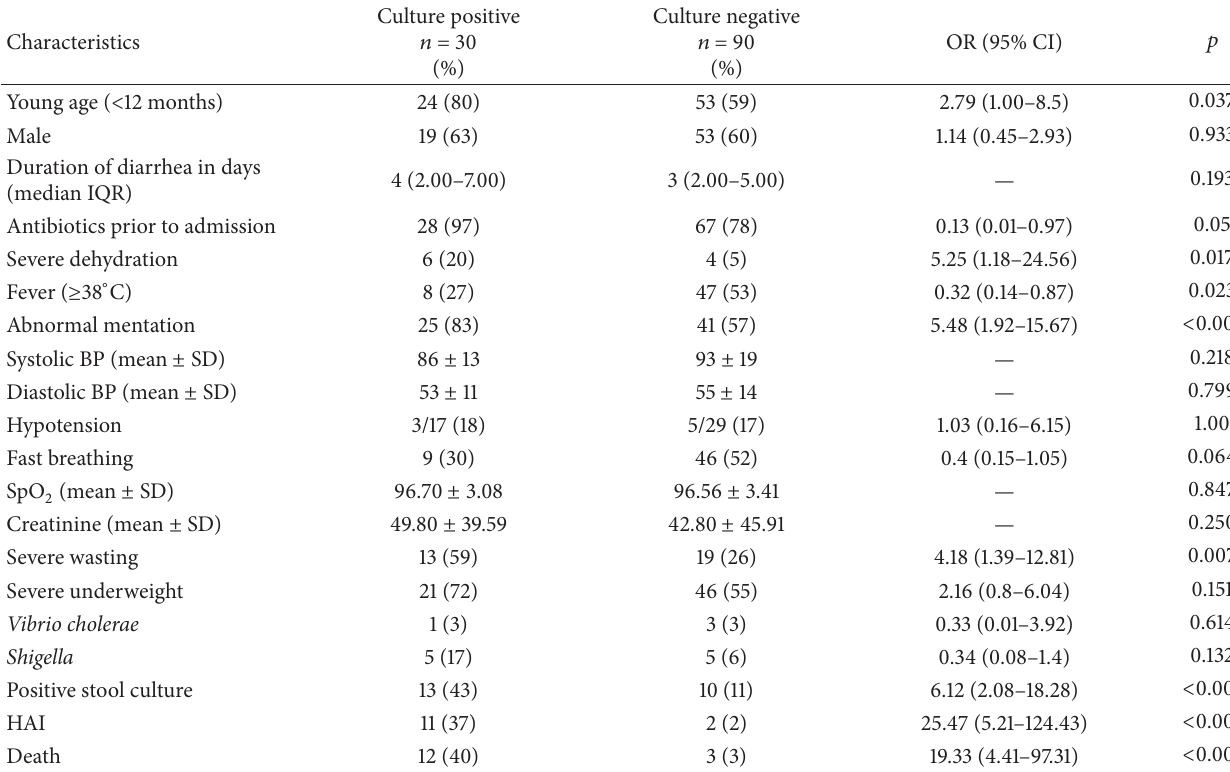
Table 1: Characteristics of under-five diarrheal children with (cases) and without (controls) Klebsiella bacteremia at hospitalization and their outcome during hospitalization.